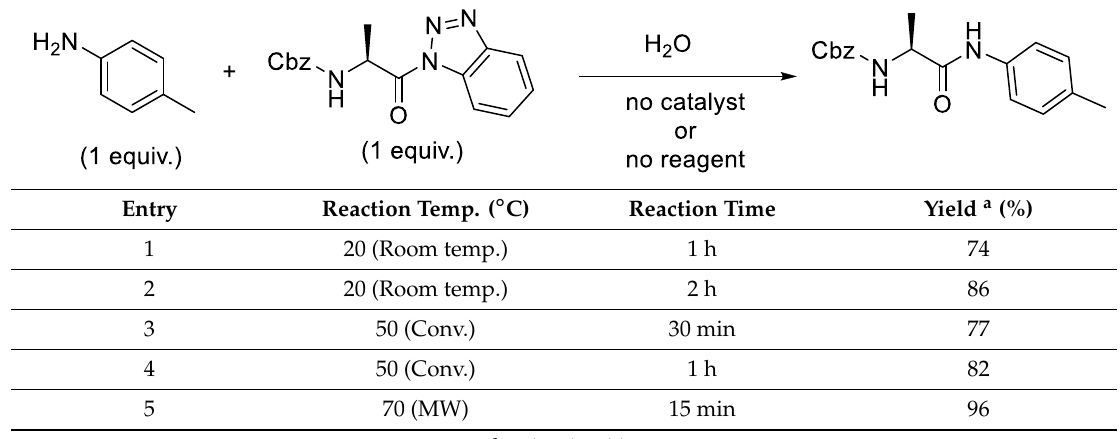
Table 1. Optimization of reaction condition.